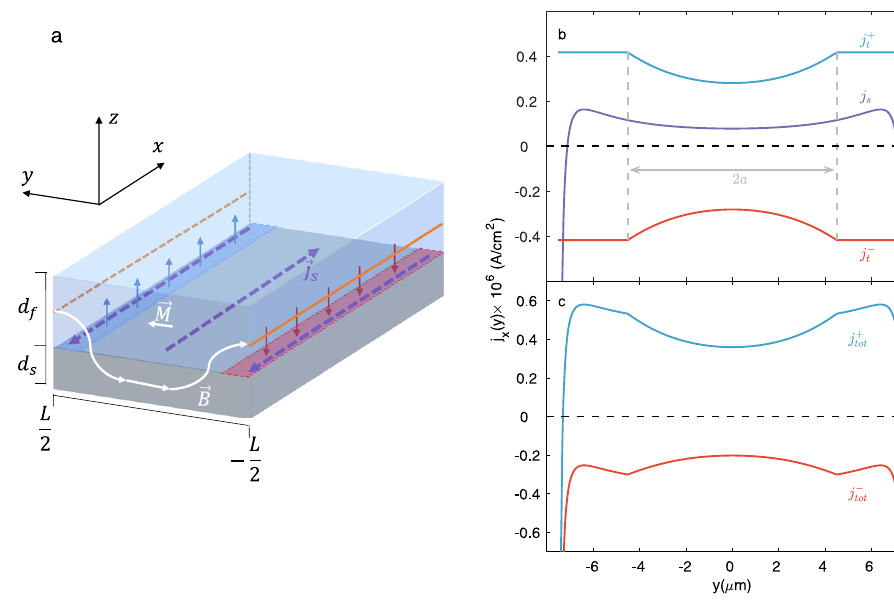
Fig.4|Theoreticalmodel.a SchematicdiagramofanS(gray)/F(blue)bilayerfully opposite phases of the ac cycle (blue and red curves) along with the screening magnetized along the y direction. The orange lines represent auxiliary wires (at current density (purple curve). The central fi eld-free region 2 a is depicted by the y =± L /2, z =0) with linear magnetic charge density± Md f , which generate a stray region between the dashed gray lines. c Total current density j tot (transport + ! magnetic fi eld H . This fi eld induces a screening supercurrent j s ( y ) inside the S fi lm screening)atoppositephasesoftheaccycle.Inthesecalculations,thevalueof I t / I c (which determines the value of a ) was set to 0.8, implying that the system is (purple dashed lines) that generates a fi eld in the opposite direction (red and blue ! approaching the critical arrows).Thesumof the fi elds ( B )generated bythe Sand Flayersinthe zy planeis represented by the white line. b Calculation of the transport current densities at